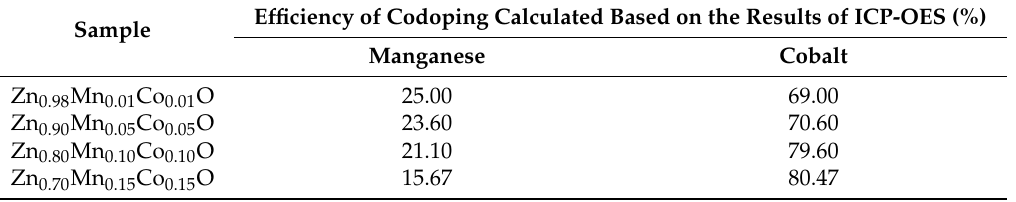
Table 6. Efficiency of ZnO codoping with Mn 2+ and Co 2+ ions.